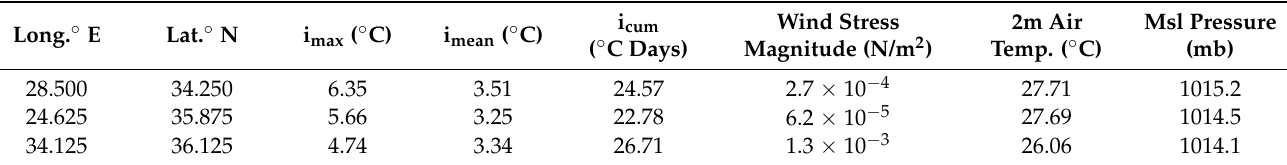
Table 3. The EMED most intense (14–20 May 2020) MHW events characteristics (mean duration (Days), i max ( ◦ C), i mean ( ◦ C), i cum ( ◦ C days)), wind stress magnitude (N/m 2 ), 2 m air temperature ( ◦ C) and mean sea level pressure (mb) with the corresponding Longitude and Latitude in degrees. Long. ◦